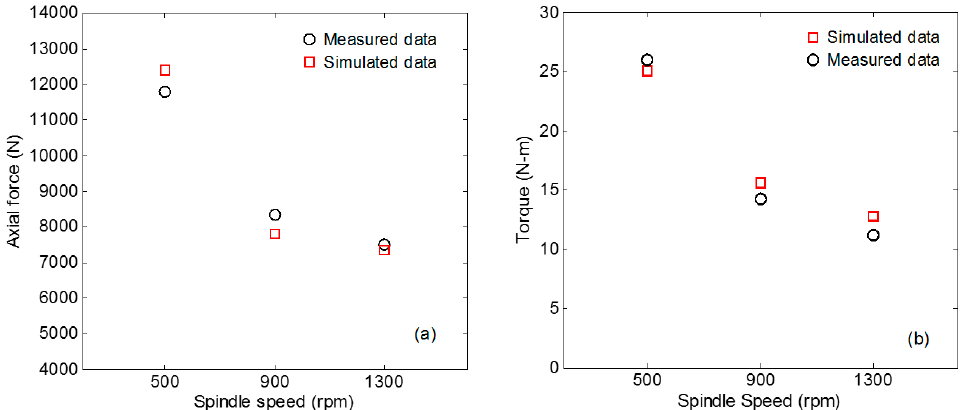
Figure 10. Data comparison verification of axial force and torque. ( a ) Comparison of axial force data; ( b ) comparison of spindle torque data.